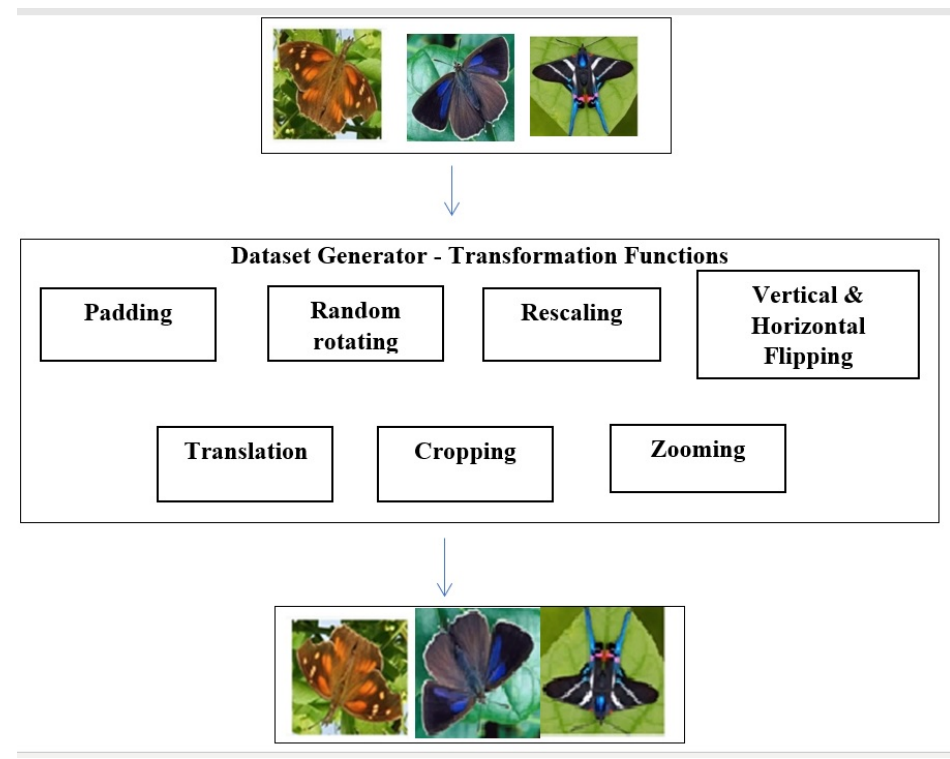
Figure 1. Data Augmentation